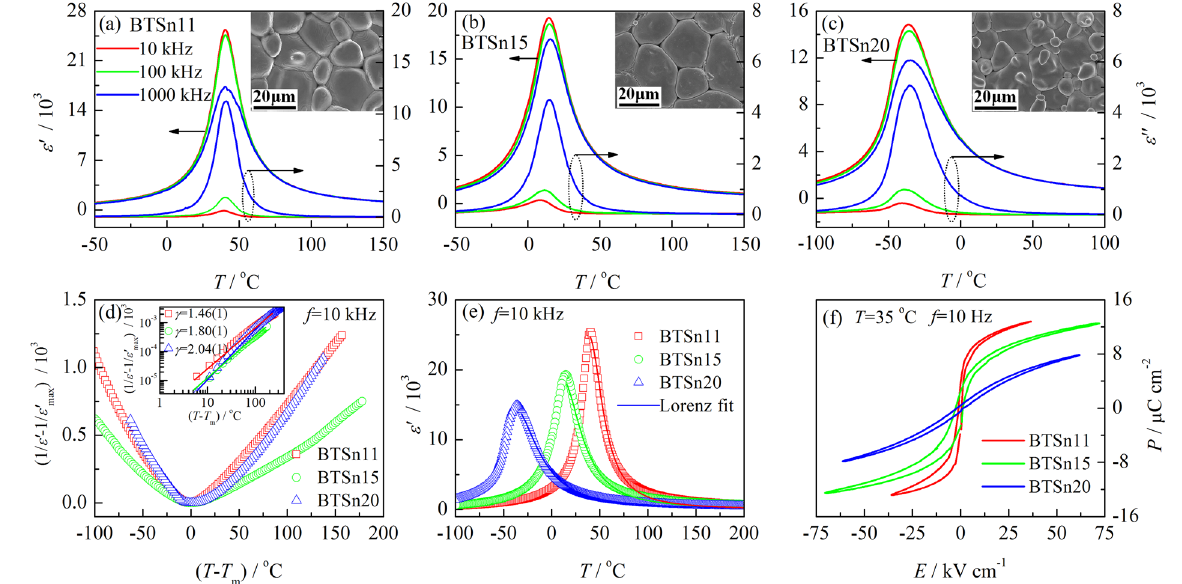
Figure 2. ( a–c ) The temperature dependences of the real ( ε ′ ) and imaginary parts ( ε ″ ) of the complex dielectric permittivities of the BTSn11, BTSn15 and BTSn20 ceramics. The insets in ( a – c ) are SEM images of the surface of the ceramics; ( d ) the temperature dependences of the inverse dielectric permittivity. In the inset of ( d ), the same dependences are plotted on a log-log scale, where the values of the parameter were estimated in accordance with Eq. (1) for T − T m > 100 °C; ( e ) the temperature dependences of the dielectric permittivity of the BTSn ceramics. The solid lines are fitting curves derived by using Eq. (2); ( f ) P - E loops of the BTSn11, BTSn15 and BTSn20 ceramics measured at 32 °C and 10